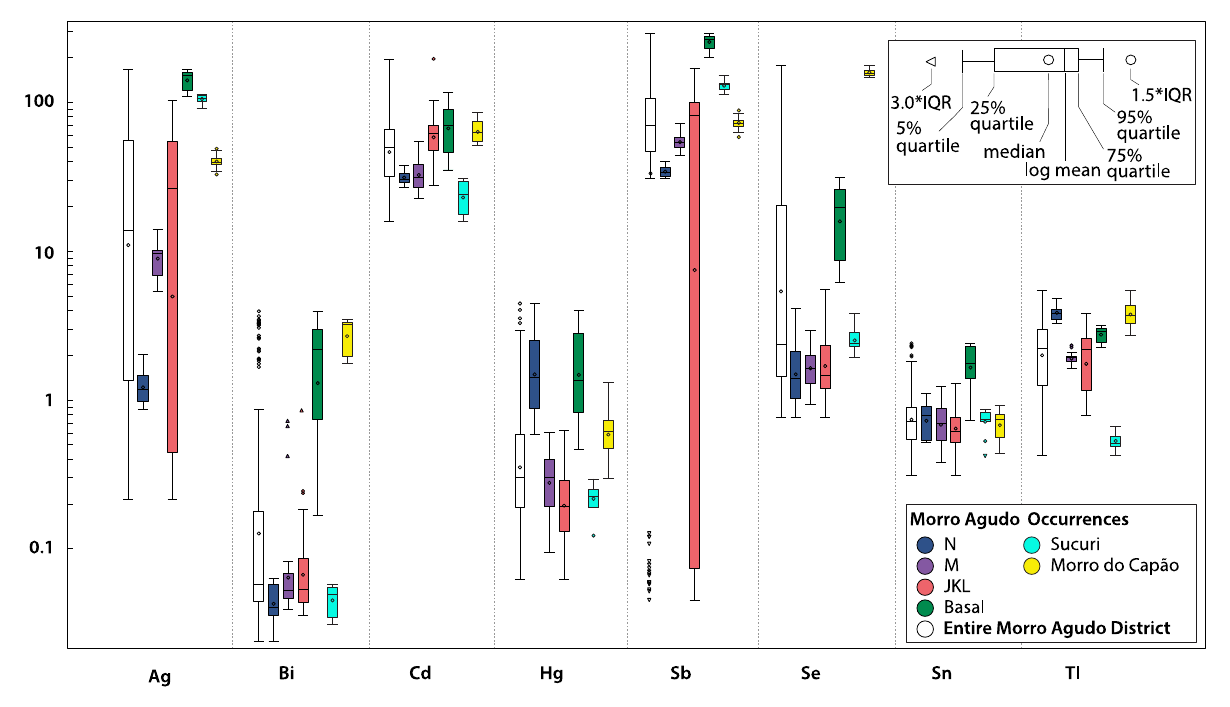
Figure 14. Box-and-whisker plots of common trace elements in galena within the Morro Agudo deposit and district occurrences. All units are in ppm. Note the logarithmic scale and corresponding mean value.